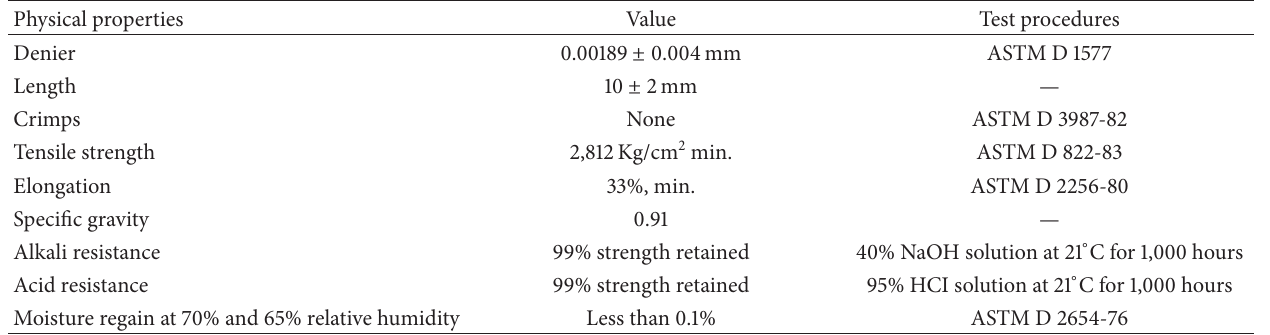
Table 1: Physical properties of short polypropylene fiber used in the